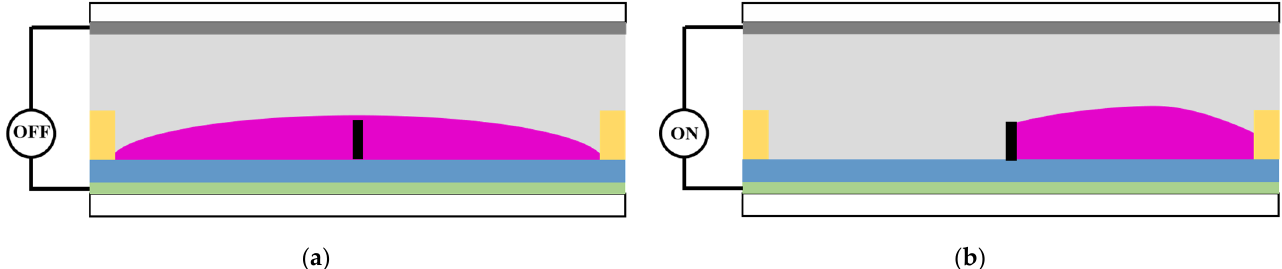
Figure 2. Two-dimensional structure diagram of one pixel in EWD. ( a ) The color of oil can be displayed when driving voltage is 0 V. ( b ) The color of the substrate can be displayed when driving voltage is greater than the threshold voltage.